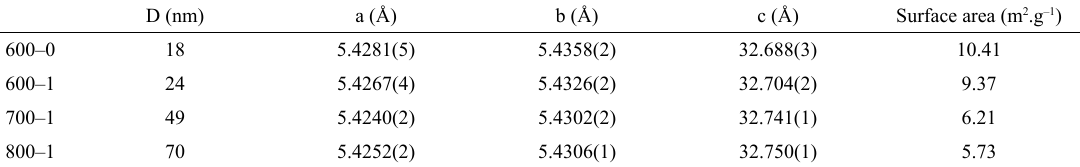
Figure 2. Graphical results of Rietveld refinement for the samples according to the temperature of annealing Table 1. Crystallite size, lattice parameters and surface area of the synthesized powders.